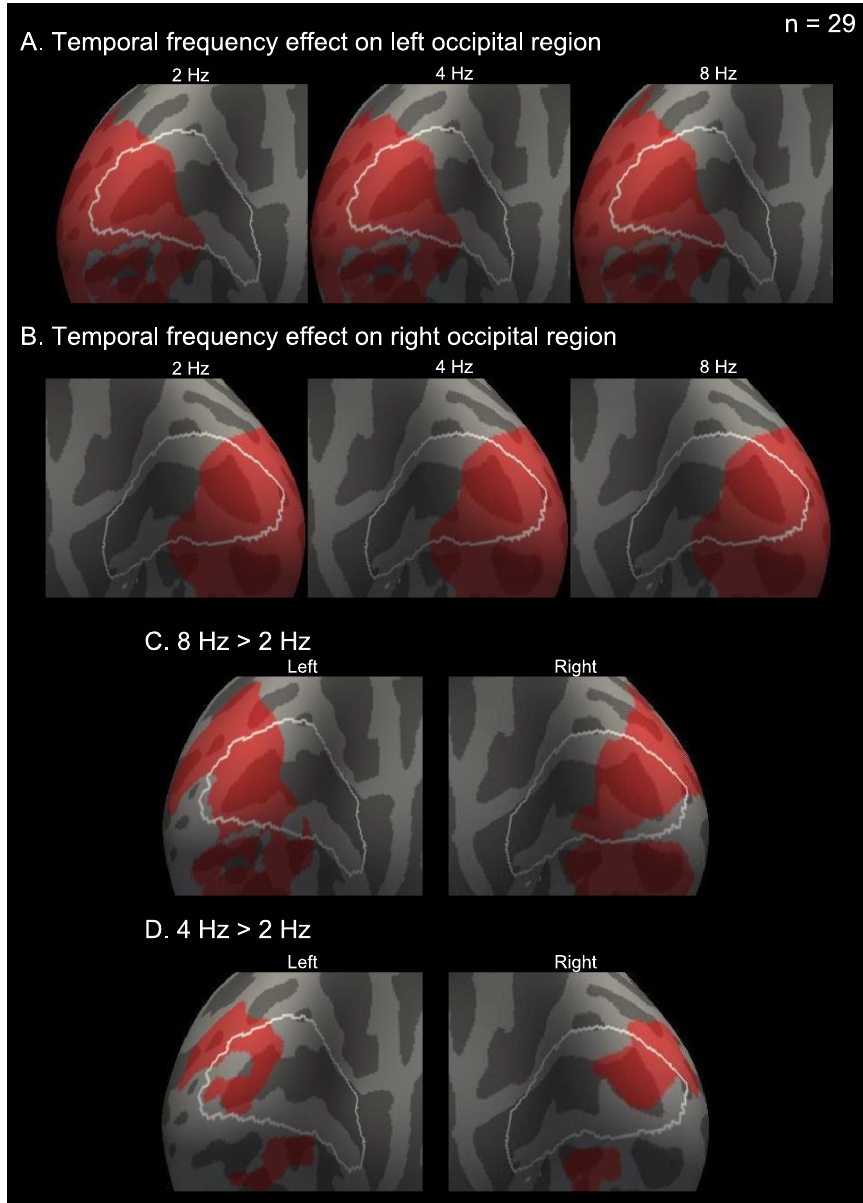
Fig 3. Significant brain activity derived from group analysis (n = 29). Red regions indicate statistically significant clusters activated by each temporal flicker frequency (2, 4, and 8 Hz) on the left (A) and right (B) hemispheres. (C) Statistically significant clusters in which the brain activity of 8 Hz is higher than that of 2 Hz (8 Hz > 2 Hz contrast). (D) Statistically significant clusters in which the brain activity of 4 Hz is higher than that of 2 Hz (4 Hz > 2 Hz contrast). Brain surfaces are shown from a posterior/medial viewpoint. White lines on the brain surfaces indicate the border of V1. Statistical significance is cluster-wise corrected P < 0.05.